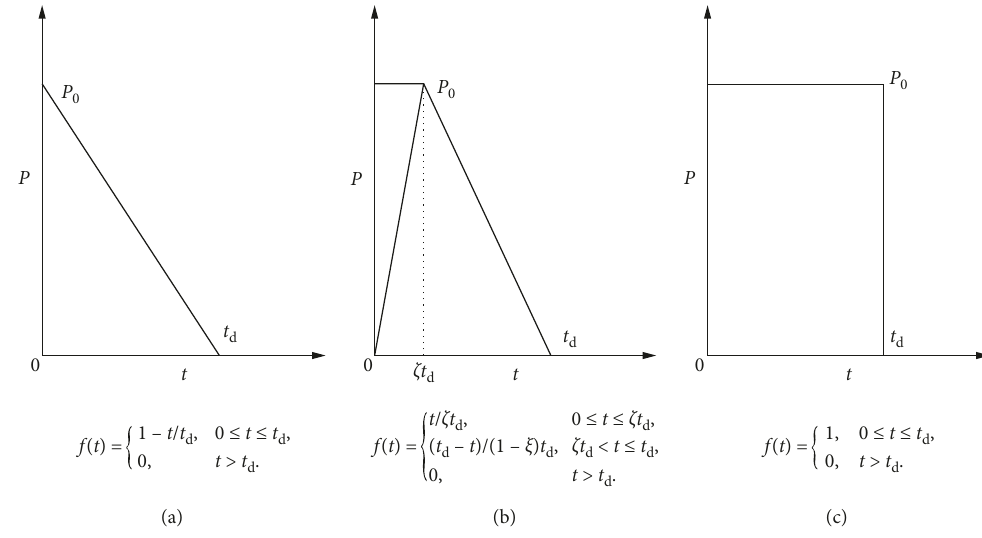
Figure 2: Different shapes of vehicle impact load. (a) Right triangle. (b) Triangle with time growth. (c) Rectangle.